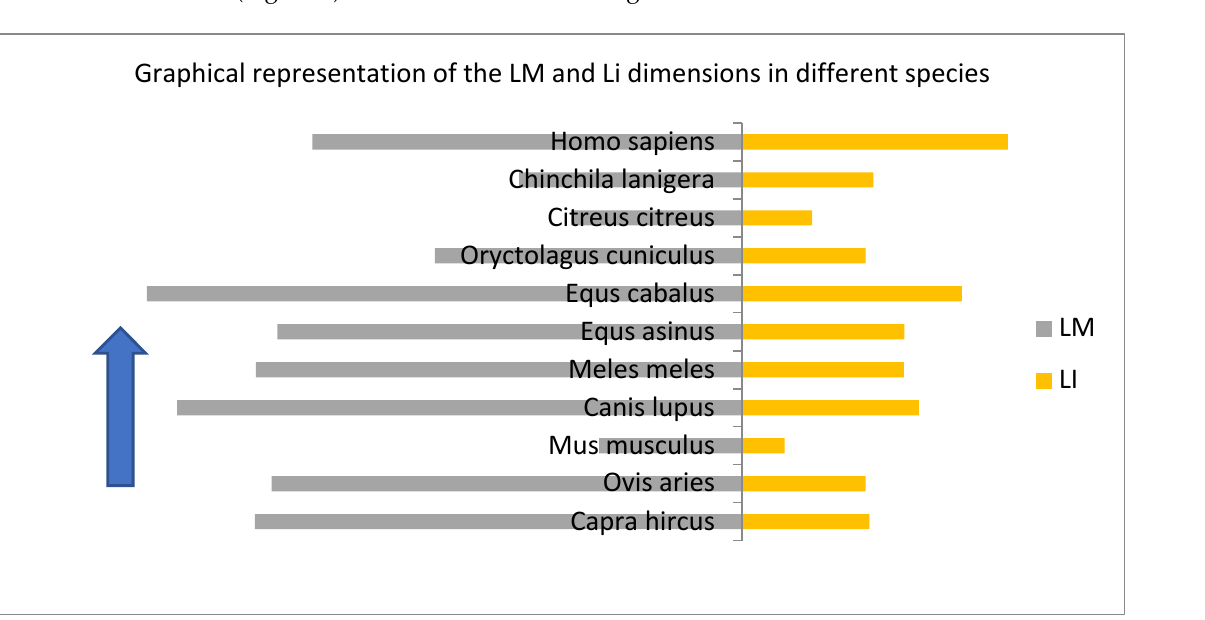
Figure 8. Representation of the malleal proportions in order of the LM:Lhm ratio (descending). This representation places on the upper part of the chart values for the malleus of some rodents along with those of humans, small ruminants and equids, while the ones from carnivores (wolf and badger) are placed in the lower part of this chart. Such a situation may suggest some kind of correlation with the facts linked to the frequency ranges that are associated with different species’ audible spectrum [60] that points to a higher frequency for mice (up to 91,000 Hz), carnivores (up to 64,000 Hz) and much lower ones for ruminants (sheep) or non-ruminants (horse) (up to 30,000 Hz) or even chinchillas and humans (20,000–22,000 Hz). The widely used ratio of malleus:incus length ratio for the same series of species (Figure 9) reveals another interesting situation.